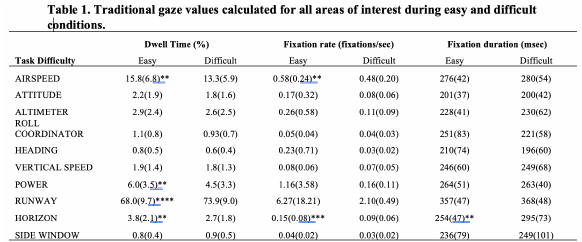
Note. Mean (standard deviation) values for all traditional gaze measures across all areas of interest (AOI) and task conditions (easy versus difficult). Significant changes between task difficul- ties and their corresponding dependent variable and AOI